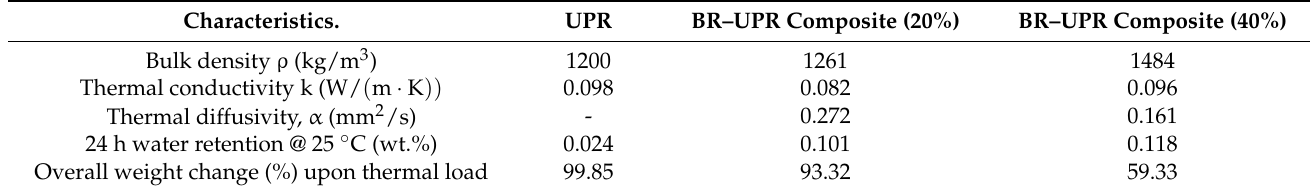
Table 1. Thermal and physical characteristics of bauxite residue (BR)–unsaturated polyester resin (UPR) composites. Characteristics.